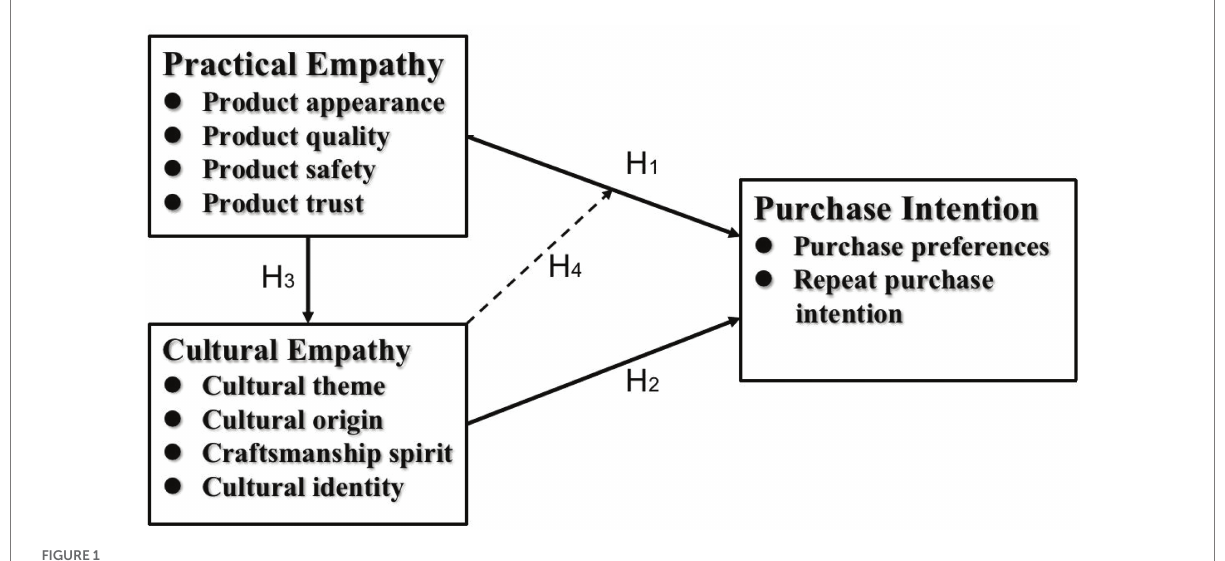
FIGURE 1 Research